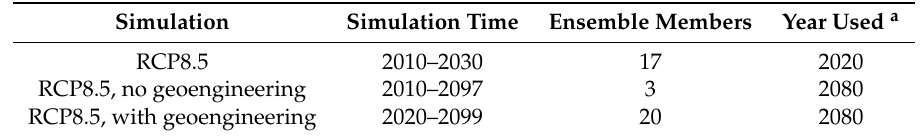
Table 1. The simulations used in this study performed with the Community Earth System Model, version 1 (CESM1), using the Whole Atmosphere Community Climate Model (WACCM) as its atmospheric